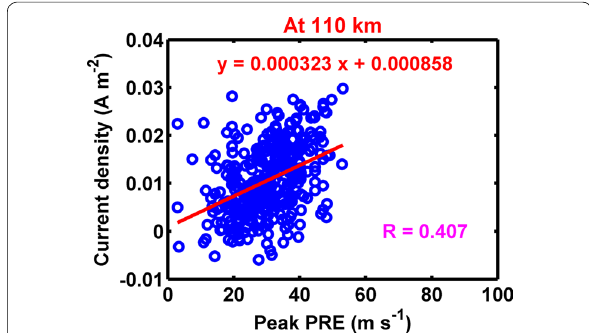
Fig. 6 Scatter plot showing the correlation of eastward current density around 1700 LT versus the peak PRE (during the equinoctial months of 2011–2013) at the altitude of 110 km over (10° N, 100° E; GAIA co-ordinates) near Chumphon in